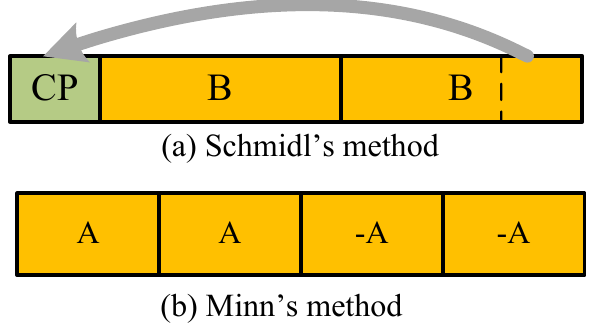
Figure 1. Conventional state-of-the-art designs of the OFDM preamble for